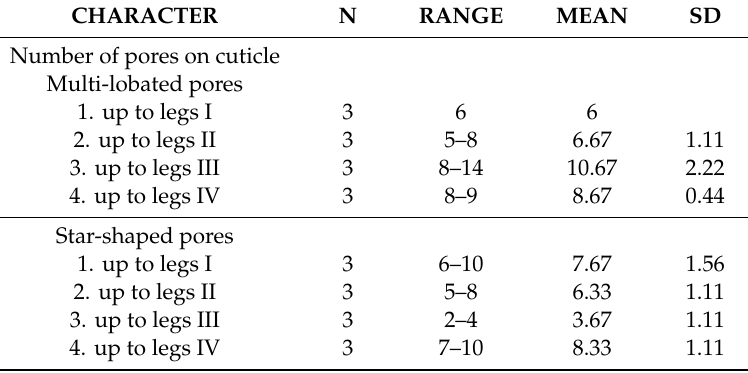
Table 3. Number of star-shaped pores of four and five tips, the most abundant, on dorsal cuticle